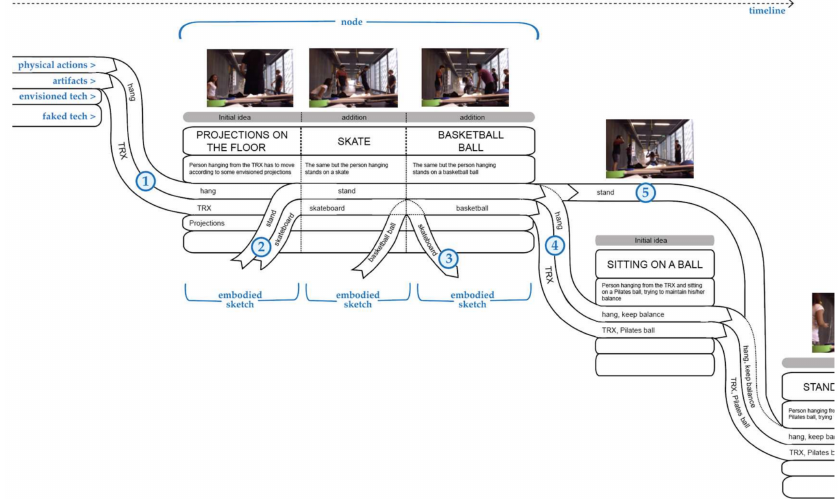
Figure 4. Close-up of the Bodystorming Braid of four embodied sketches: “projections on the floor”, “skate”, “basketball ball” and “sitting on a ball”. Annotations (blue text and graphics) mark distinctive components of this documentation